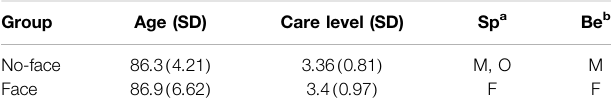
TABLE 1 | Demographic information of participants. F, M, and O indicate the participant IDs.